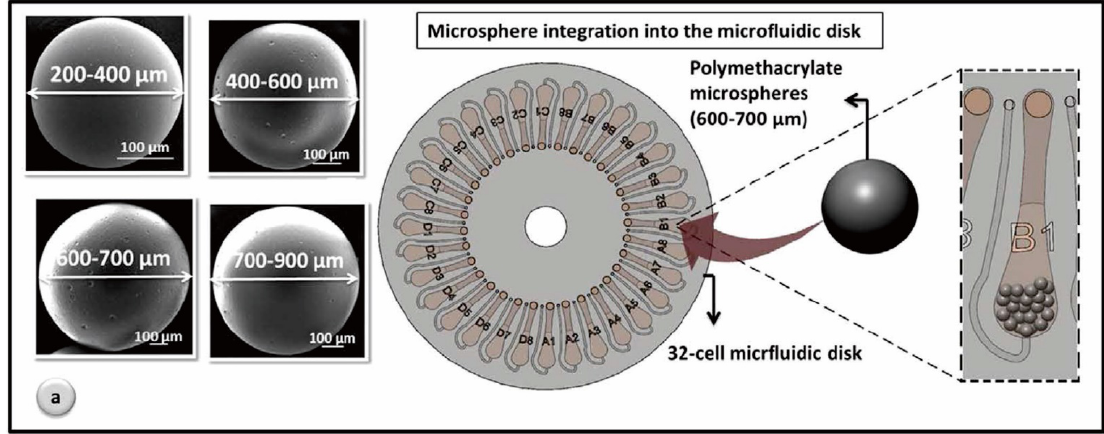
Figure 11. Microfluidic design of microsphere based DV detection ELISA platform. Figure reprinted with permission from [133]. with permission from